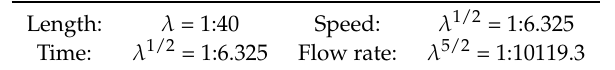
Figure 4. Flow structure and velocity in the feeding tank at discharge flow rate of 300 m 3 /s. Table 1. Scaling parameters between the model and the